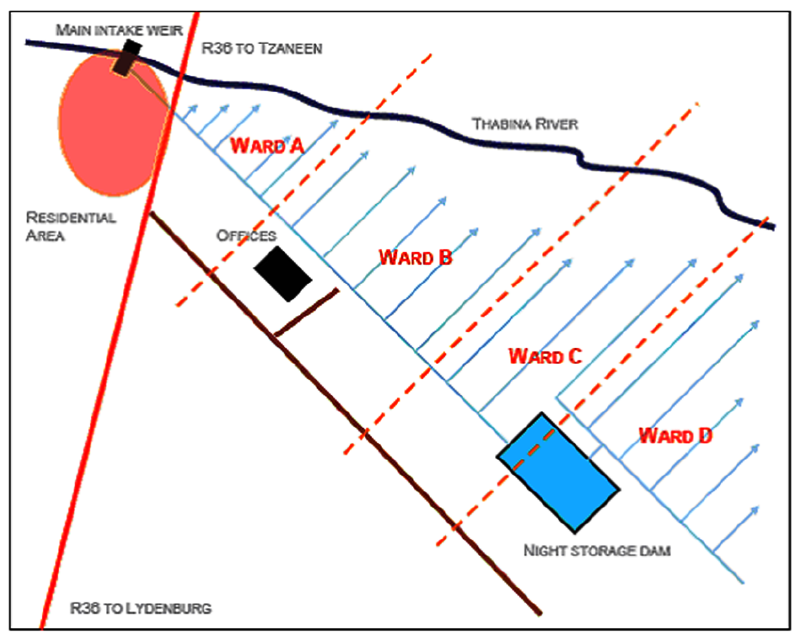
Figure 1 Sketch of Thabina irrigation